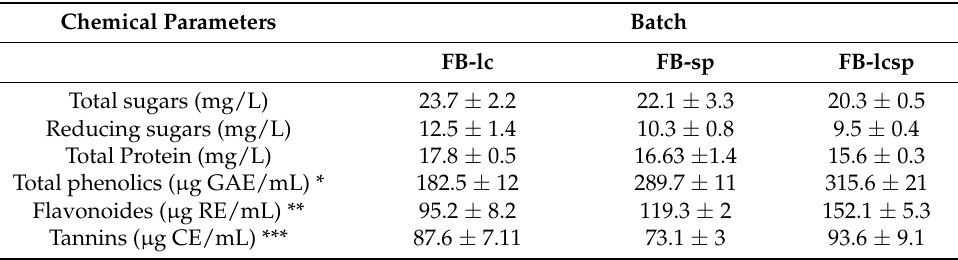
Table 2. Total sugars and proteins, total phenolic compounds, flavonoids and tannins contents of obtained